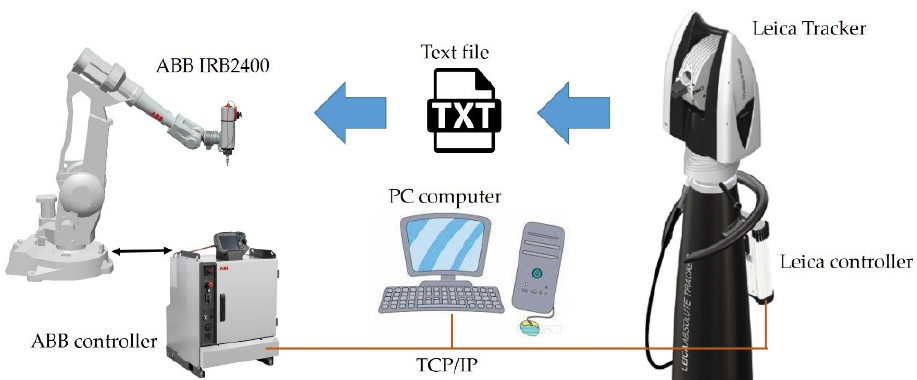
Figure 15. Communication diagram of the Laser Tracker—ABB Robot.